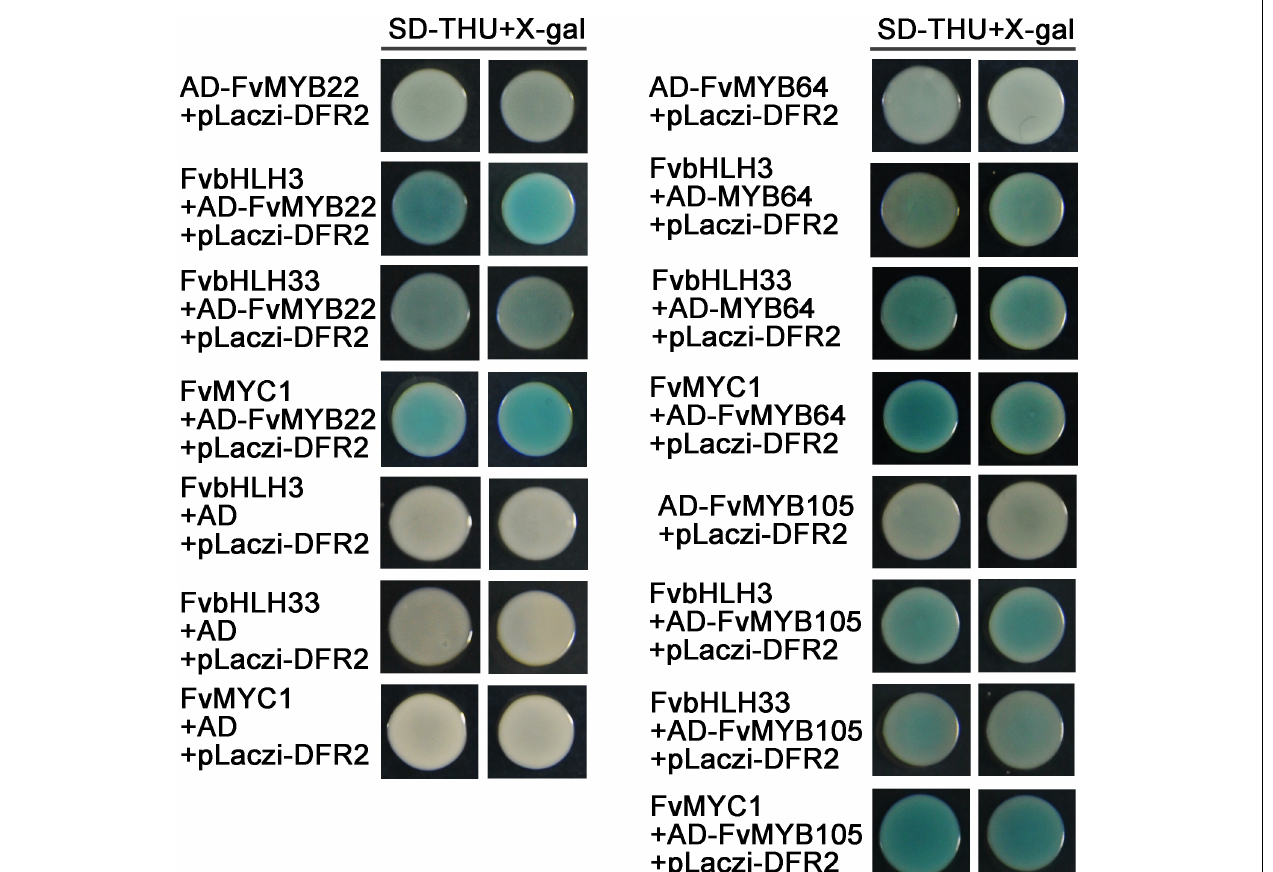
FIGURE 7 | The effect of interactions between MYB and bHLH proteins on the DFR2 promoter fused with LacZ reporter gene. Yeast cells were grown on selective medium (SD-Trp, -His, -Ura; SD-THU) with 80 mg/L X -gal. Blue precipitates represent cumulative β -galactosidase activity resulting from the activation of the LacZ reporter gene by binding. Two representative colonies were shown for each